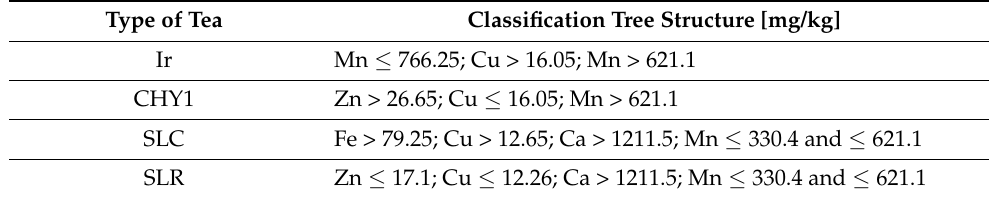
Figure 3. Classification tree for samples of tea. The number is the node number. (Figure S1 in the Supplementary Materials presents full version of the tree). Table 2. The distribution of the attribute values of nodes in the tree with the selected